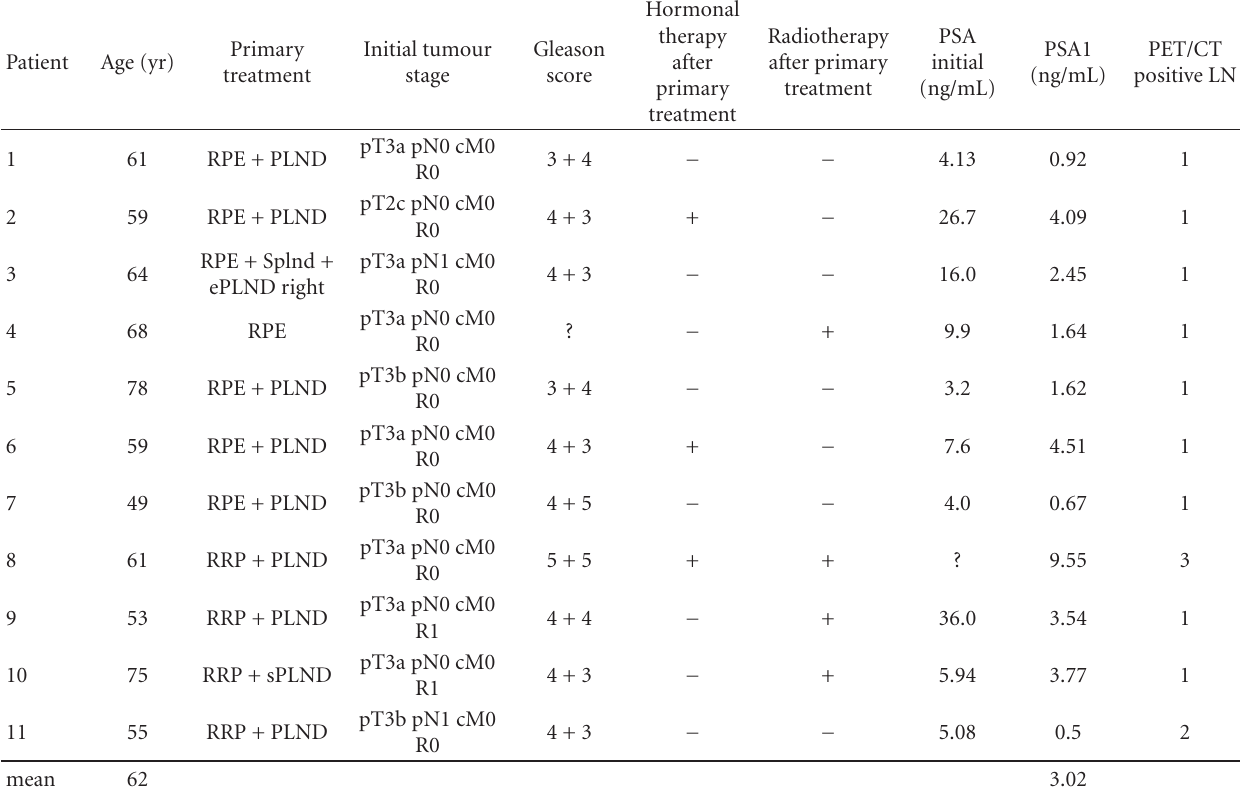
Table 1: Summary of the patient characteristics.